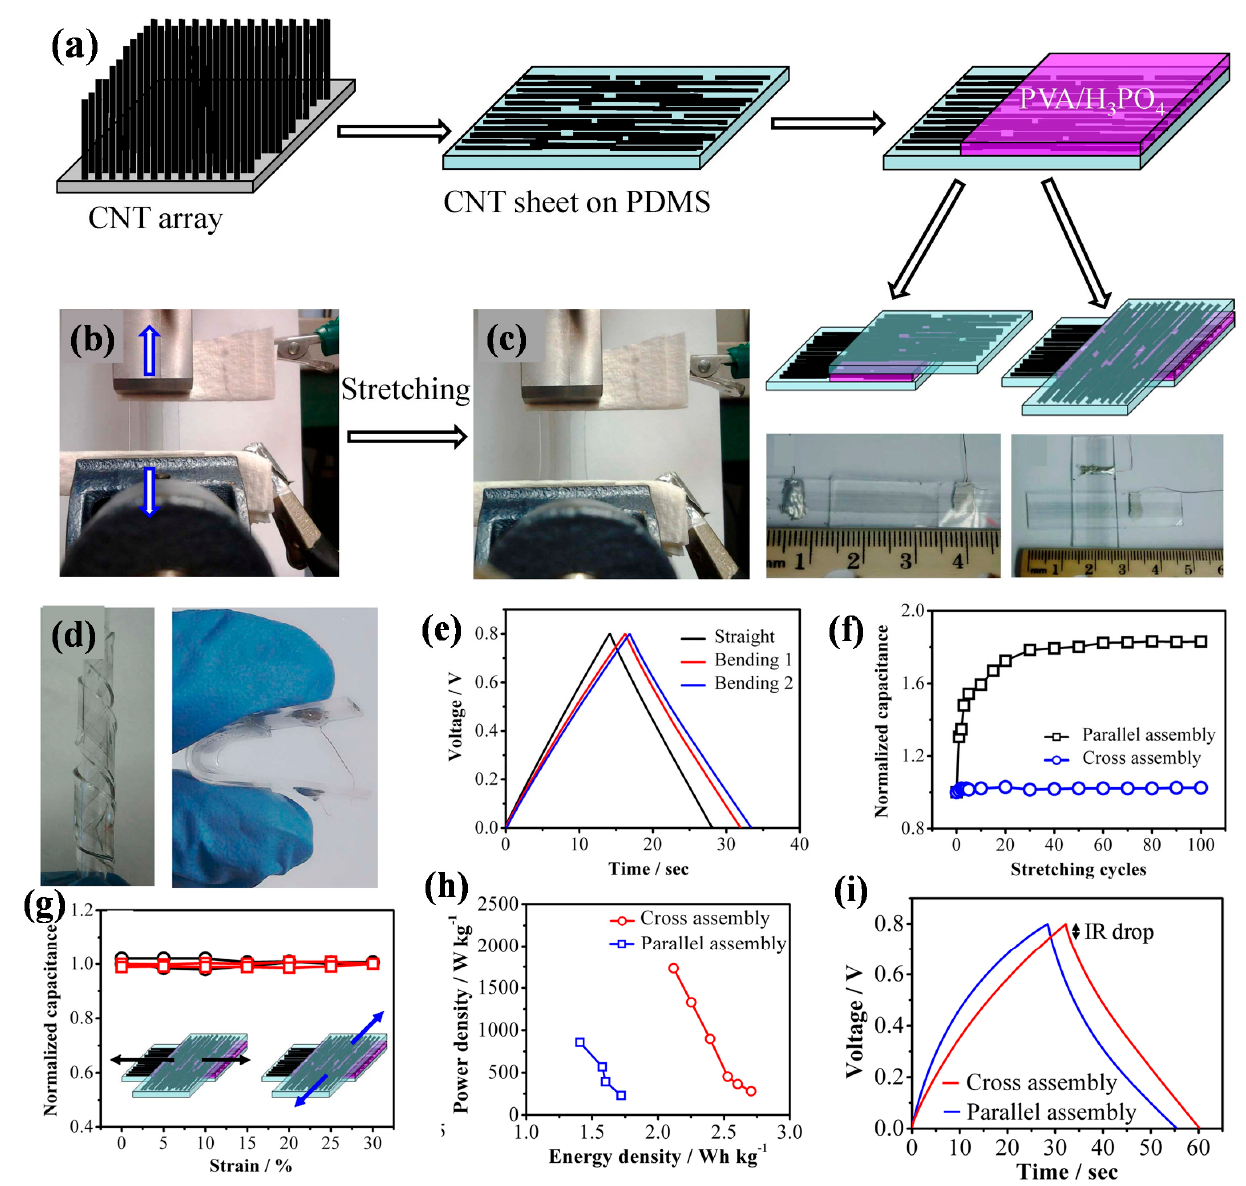
Figure 6. ( a ) Schematic illustration of the process for fabricating the transparent stretchable supercapacitor, ( b , c ) photographs of supercapacitors, before and after stretching, ( d ) photograph of supercapacitor wrapped outside along a glass tube, ( e ) GCD curves at straight, bending 1 and bending 2, ( f ) normalized specific capacitance of two supercapacitor types as a function of stretching cycles, ( g ) normalized capacitance of the cross-assembled supercapacitor as a function of tensile strain as it was biaxially stretched, ( h ) Ragone plots of the both types of supercapacitors, ( i ) galvanostatic charging discharging curves of the supercapacitors at a constant current density of 0.25 A g − 1 for the parallel assembly and 0.23 A g − 1 for the cross assembly. Reproduced from Ref. [155]. Copyrights (Nature, 2014).